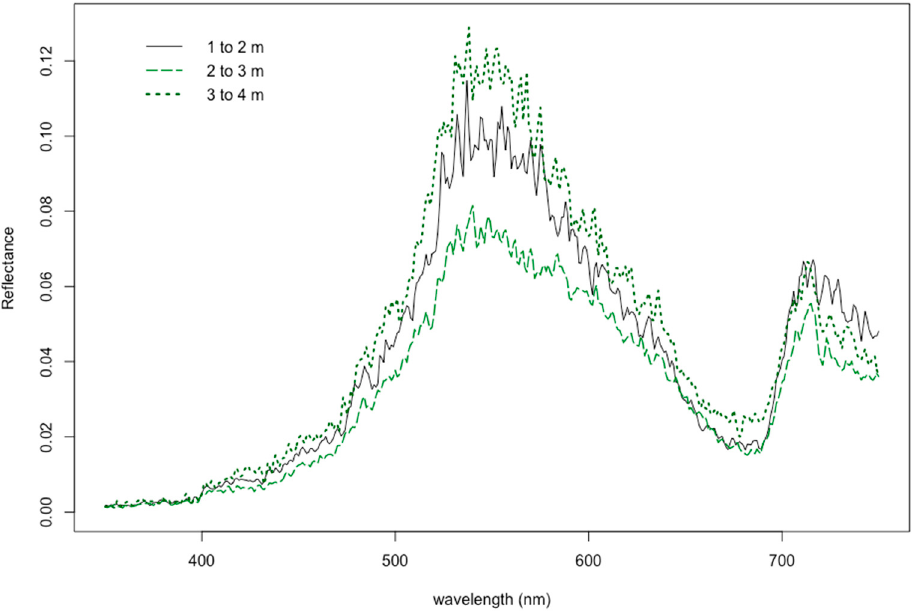
Figure 3. Differences in reflectance response based on natural growing depth.